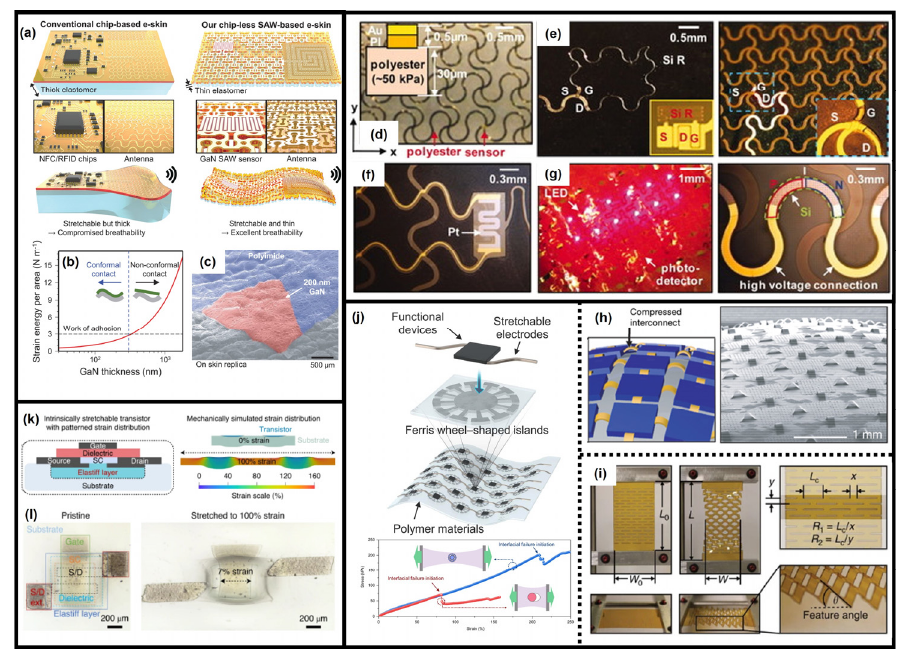
Figure 2. The typical design strategies of conducting metals and traditional inorganic materials in wearable systems. ( a ) Schematic of the wearable system with rigid devices and chip-less wearable system. ( b ) Estimation of minimum sensing material thickness required for conformal lamination on human skin. ( c ) SEM image of conformal contact between material and skin. Reproduced with permission from ref. [38] . Copyright 2021 American Association for the Advancement of Science. ( d ) Optical micrograph of an epidermal electronic skin (EES) with a filamentary serpentine (FS) de-